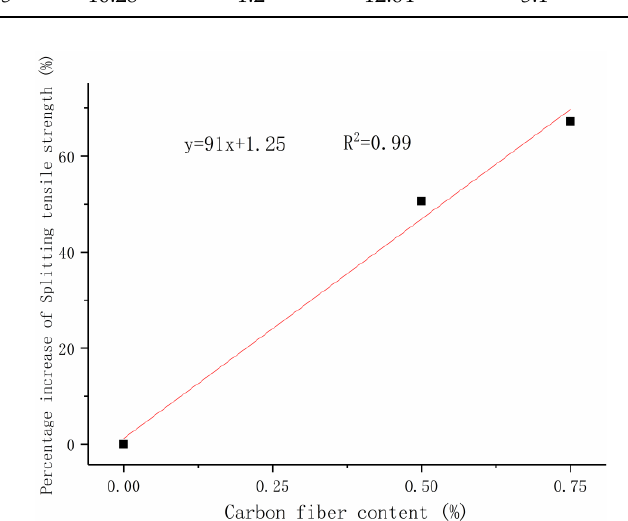
Figure 13. Relationship between splitting tensile strength and carbon-fiber content. Table 11. Calculated splitting tensile strength of carbon-fiber RPC at 28 days.